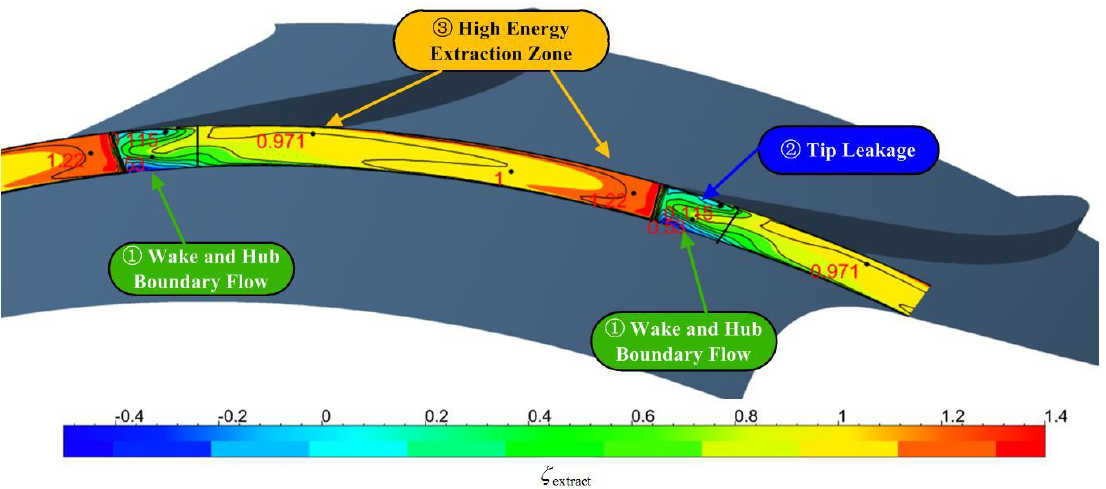
Figure 15. Energy extraction rate distribution of the designed high-reaction tip turbine.